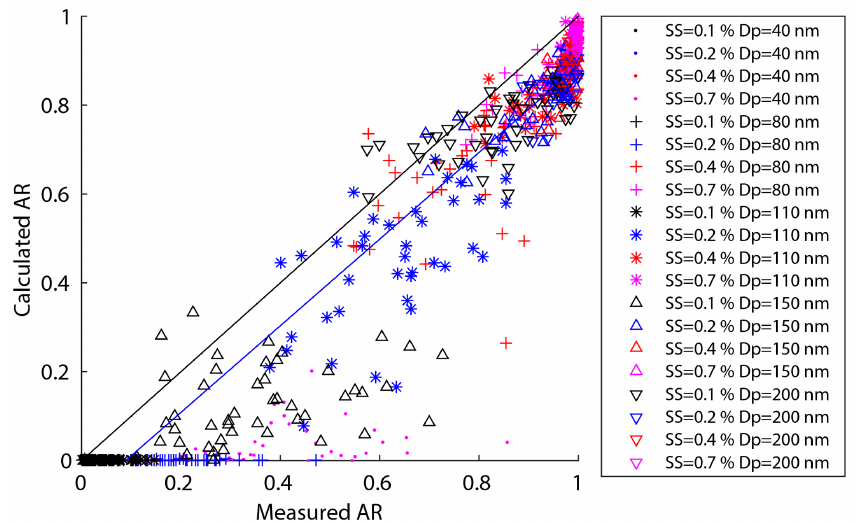
Figure 7. The predicted activation ratio based on HTDMA measurement vs. the measured activation ratio at 0.1%, 0.2%, 0.4%, and 0.7% SS for 40, 80, 110, 150, and 200nm